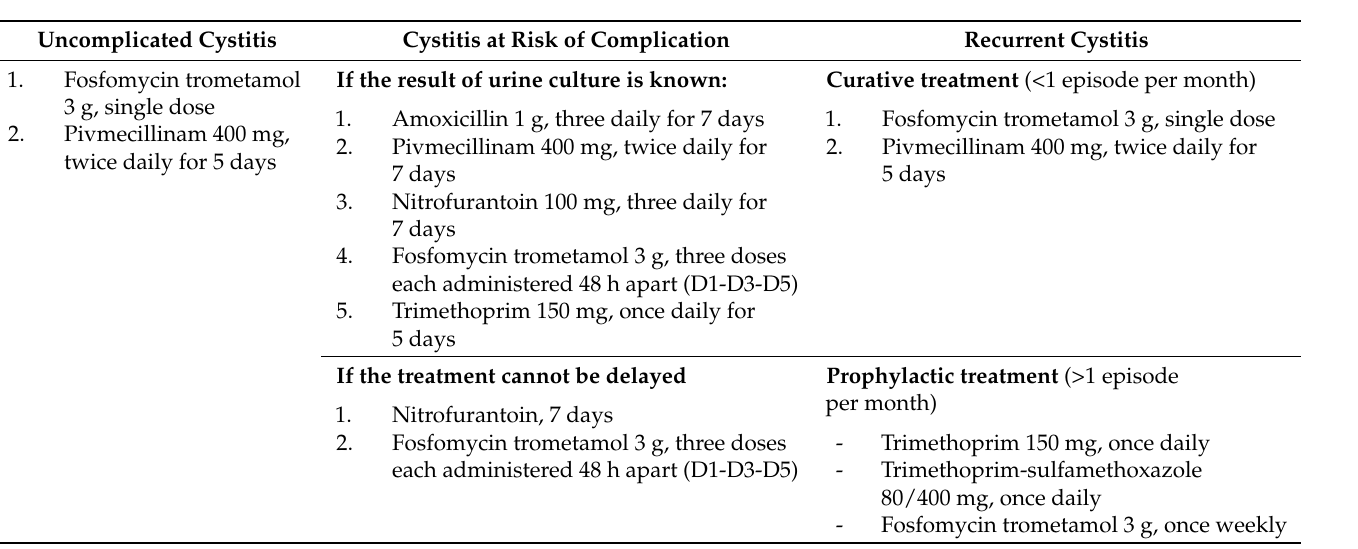
Table 1. French guidelines for cystitis management *, according to the type of cystitis, during the preliminary study and the